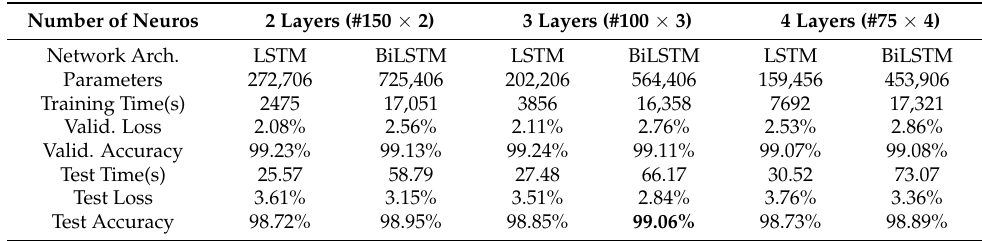
Table 3. Network performance of a multilayer LSTM and BiLSTM architecture with the total number of multilayer neurons fixed at 300.